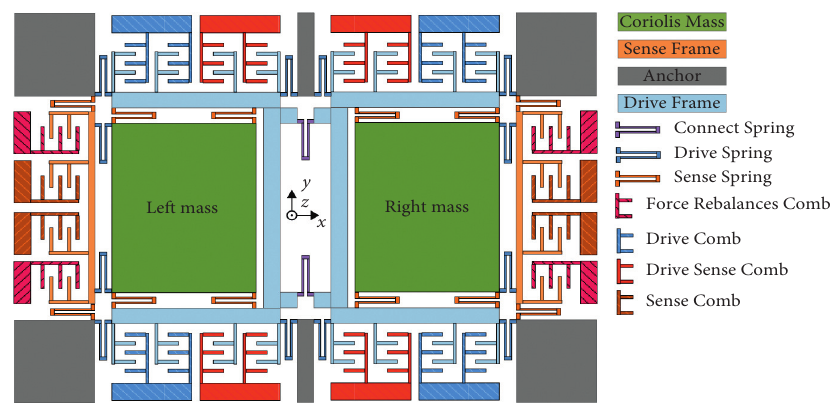
Figure 1: Schematic of the dual-mass gyroscope structure.